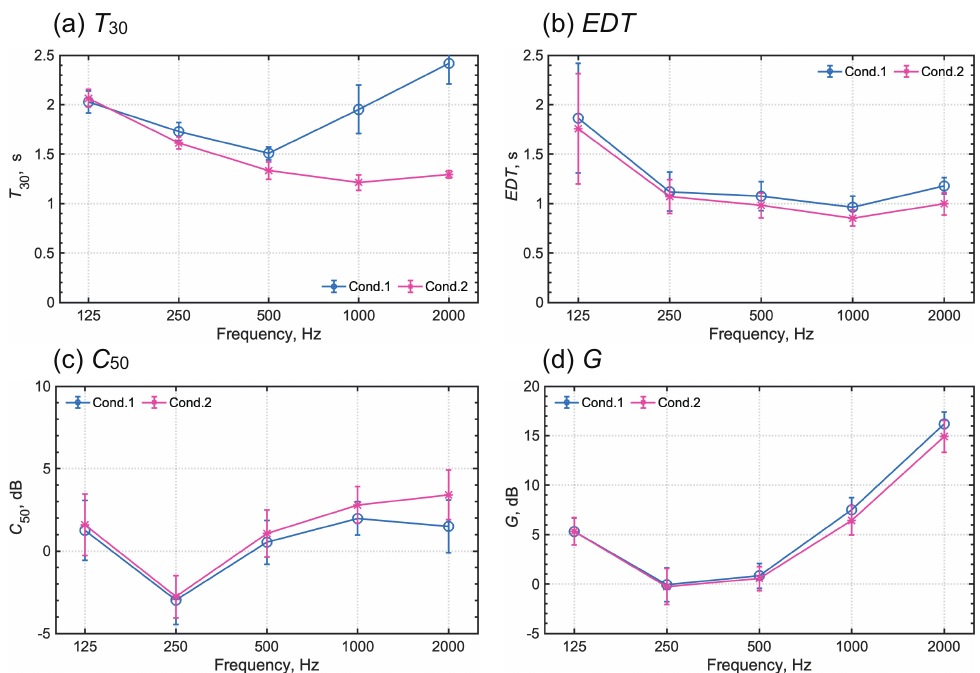
Figure 14. Comparisons of room acoustic parameters for Cond. 1 and Cond. 2: ( a ) T 30 , ( b ) EDT , ( c ) C 50 , and ( d ) G